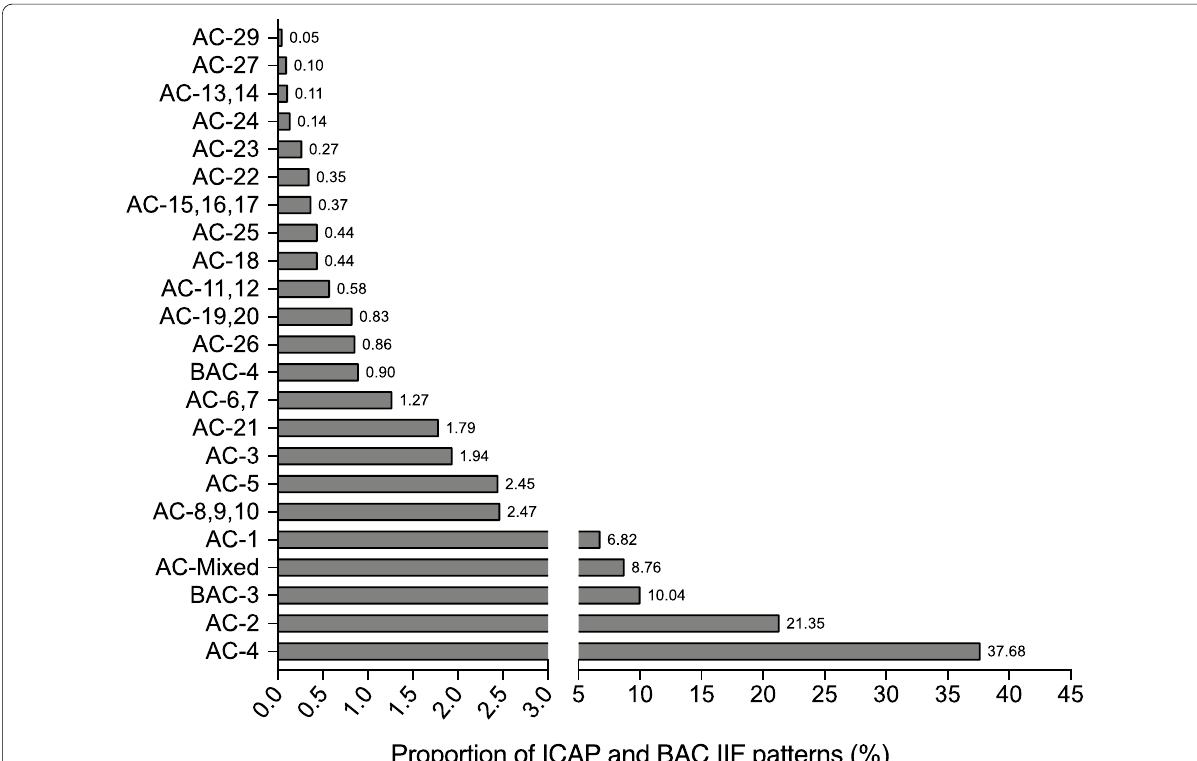
Fig. 2 Anti-cell antibodies-HEp-2 IIFA–Proportion (%) of ICAP and BAC IIF patterns in 11,478 positive samples analyzed from January to June 2017.